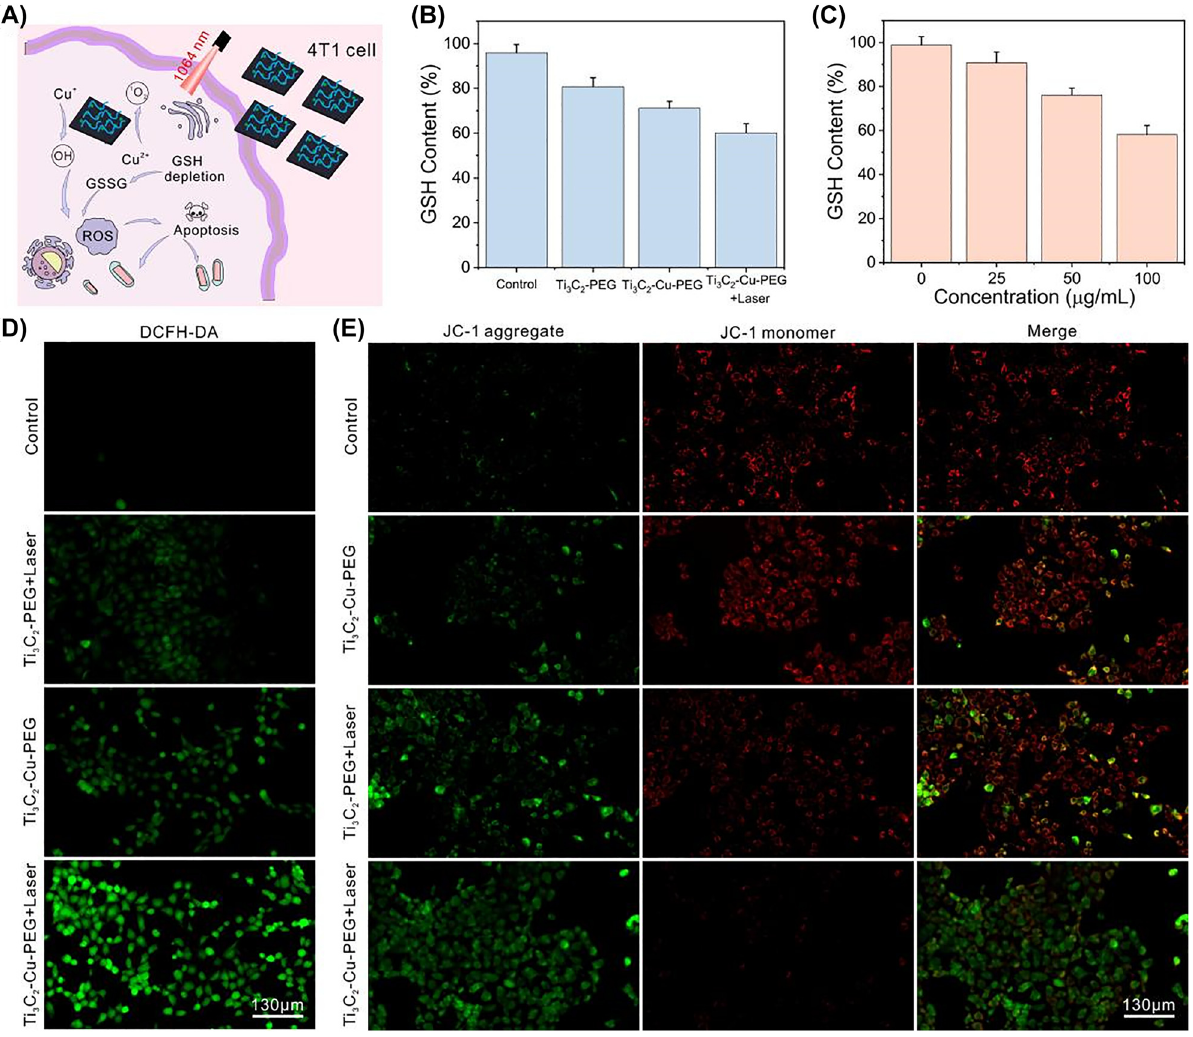
Figure 4: Intracellular ROS generation and GSH depletion. (A) Schematic illustration of ROS-generation by Ti3C2-Cu-PEG-PEG in 4T1 cells. (B) Intracellular GSH levels after various treatment. (C) Intracellular GSH levels after treatment with Ti Fluorescence images of 4T1 cells stained with DCFH-DA (D), and JC-1 (E) after various treatments, respectively. (1064 nm, 1.0 W/cm 2 , 5 min; Scale bar: 130 μ